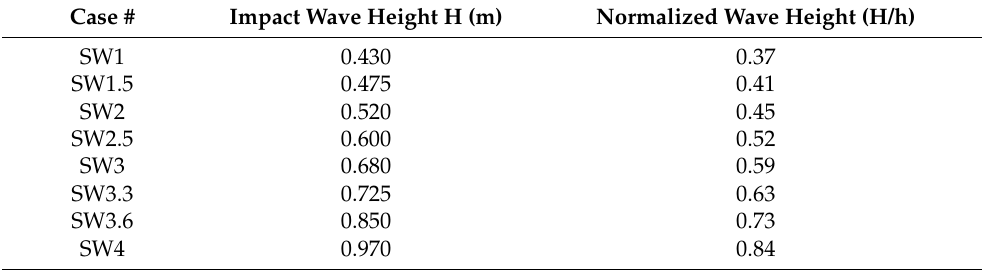
Table 2. Simulated wave heights.